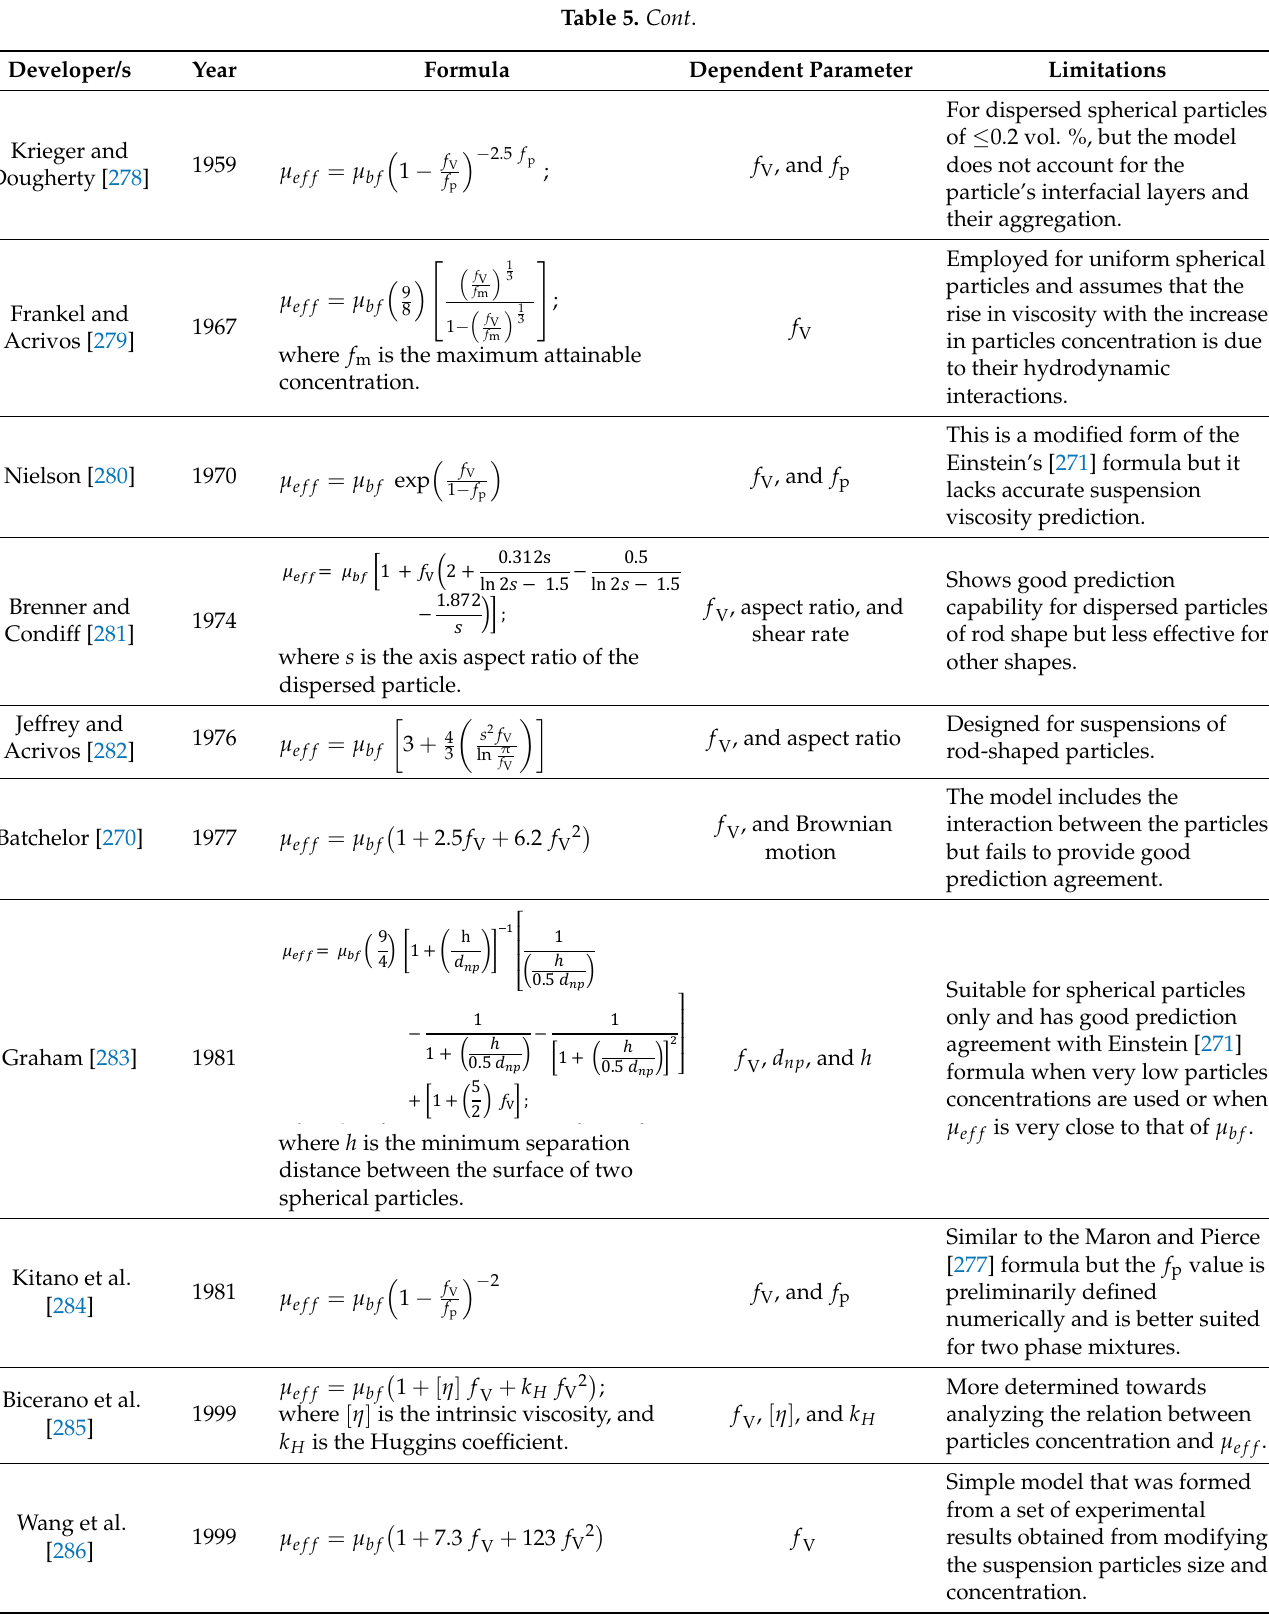
Formula Dependent Parameter Limitations